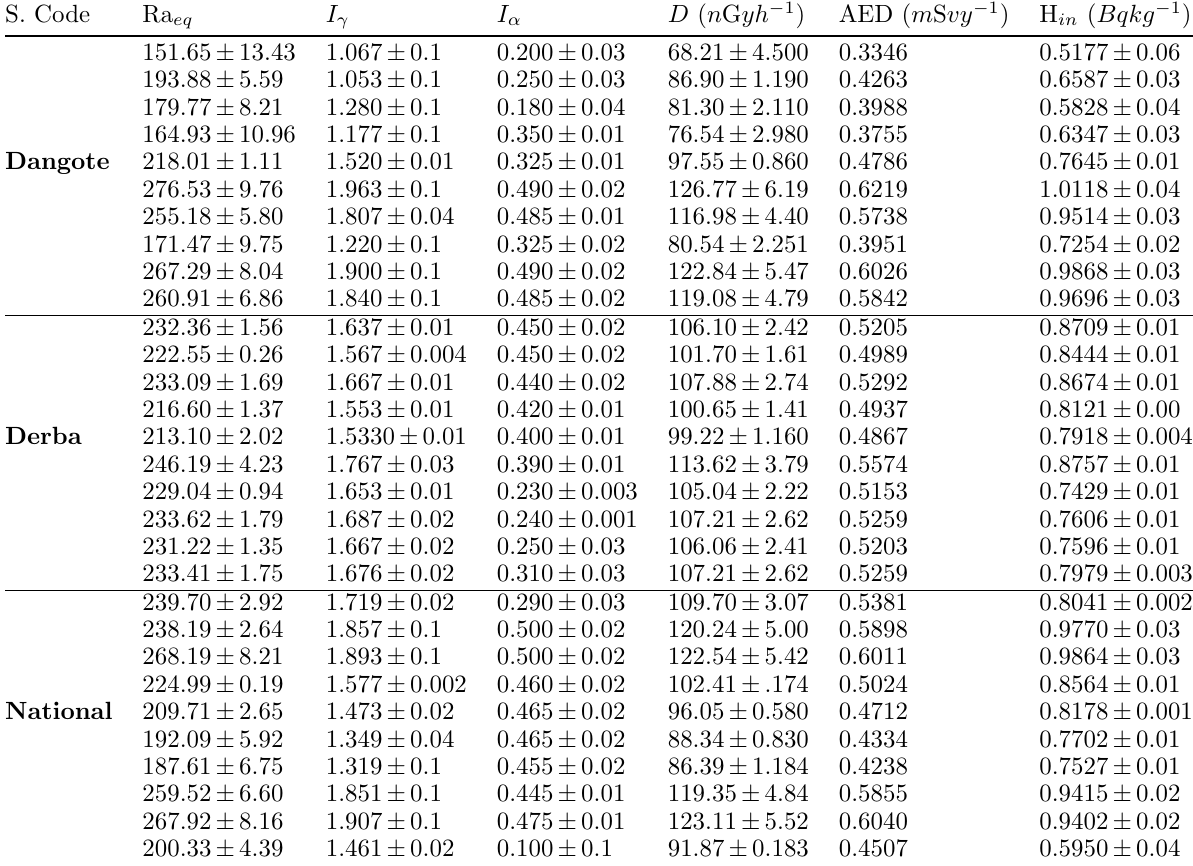
Table 3. Radiological health indices parameters values for different cement types. S.